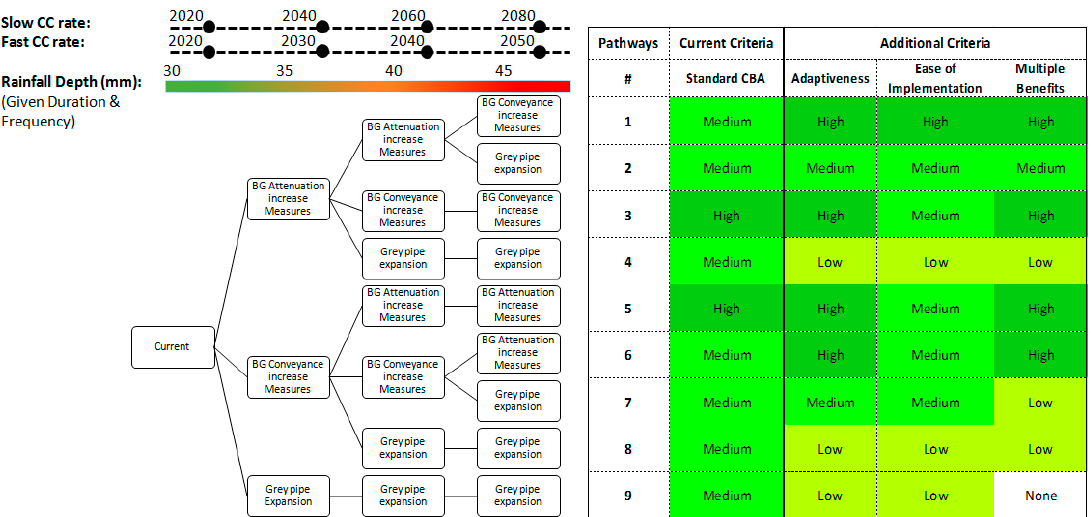
Figure 1. Assessment of adaptation pathways to meet uncertainties in future climate.